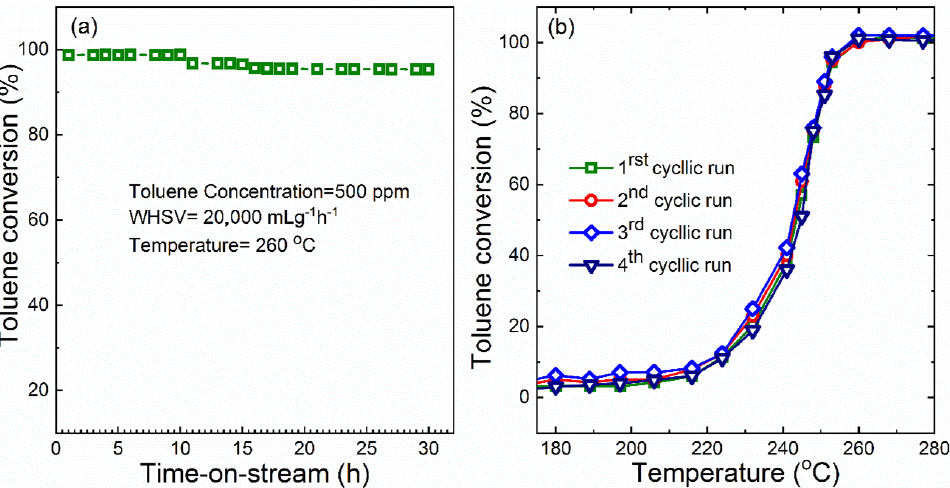
Figure 8. (a) Evolution of the catalytic long-term durability and ( b ) stability of toluene oxidation with time-on-stream over the MgCo 2 O 4 catalyst at 300 °C (GHSV = 20,000 mL g − 1 h − 1 ). time-on-stream over the MgCo ◦ C (GHSV = 20,000 mL g − 1 h − 1 2 O 4 catalyst at 300